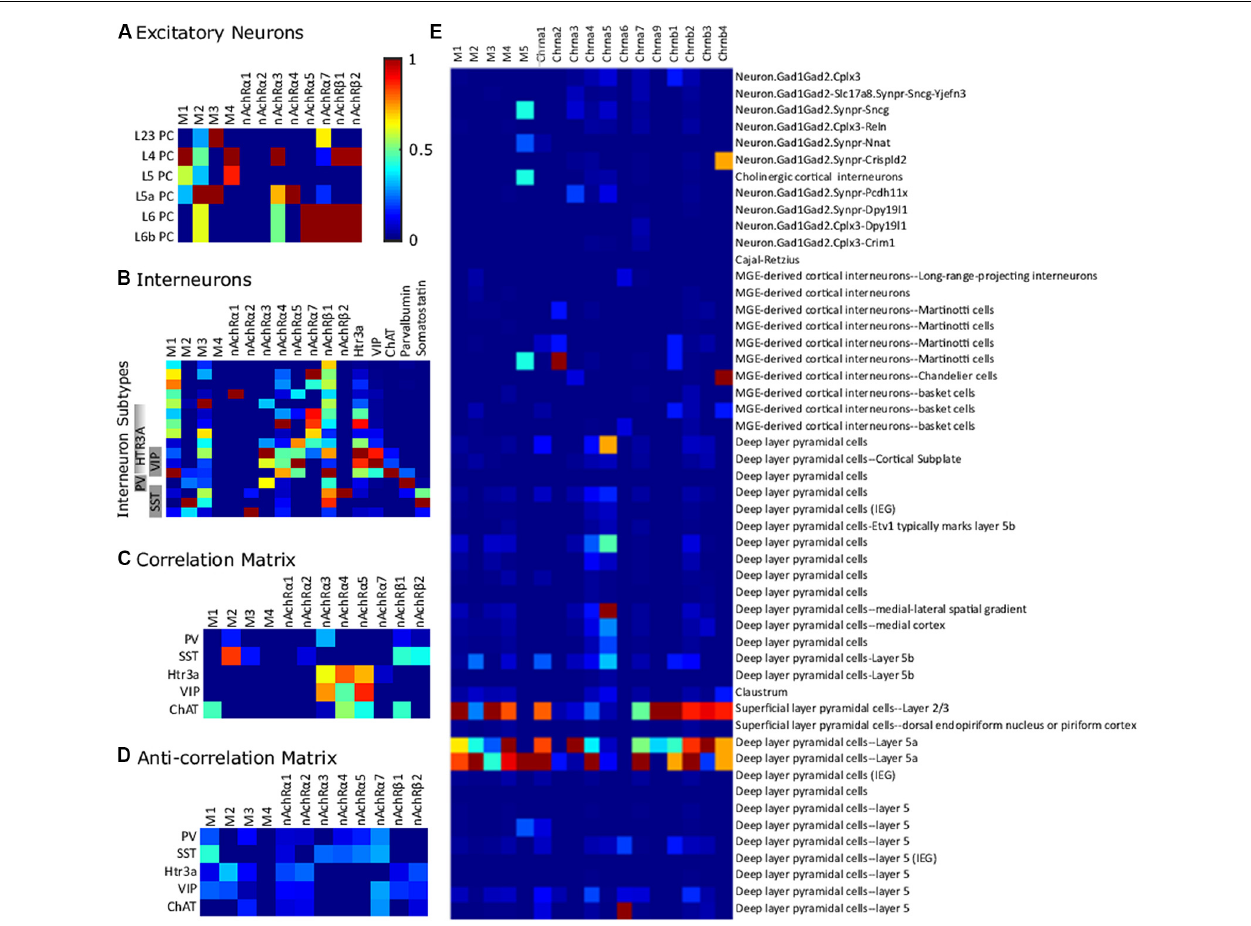
FIGURE 5 | Differential expression of cholinergic receptors in transcriptome-derived cell types. (A) Excitatory cell types. (B) Interneurons in somatosensory cortex. Gene expression is normalized to a maximum of 1 on a gene-by-gene basis. (C) Correlation matrix (positive values of correlation matrix Pearson correlation coefficient matrix). (D) Anti-correlation matrix (negative values of correlation matrix). The data is from Zeisel et al. (2018) and was collected with high-throughput single-cell RNA sequencing, a method which counts individual RNA molecules. Abbreviations: PV, parvalbumin; SST, somatostatin; VIP, vasointestinal peptide; ChAT, choline acetyltransferase. (E) Expression of ACh receptor genes across the Frontal cortex cell-clusters identified in Saunders et al. (2018). The data was collected using Drop-seq (a method which allows the use of older animals and elimination of certain technical artifacts) to profile the RNA expression of individual cells. Semi-supervised independent component analysis was used to group cells into the sub-clusters using network-based clustering (ibid). Expression levels were normalized to the highest expression across all the selected genes. In this data set, receptor expression was particularly high in L23 and L5a